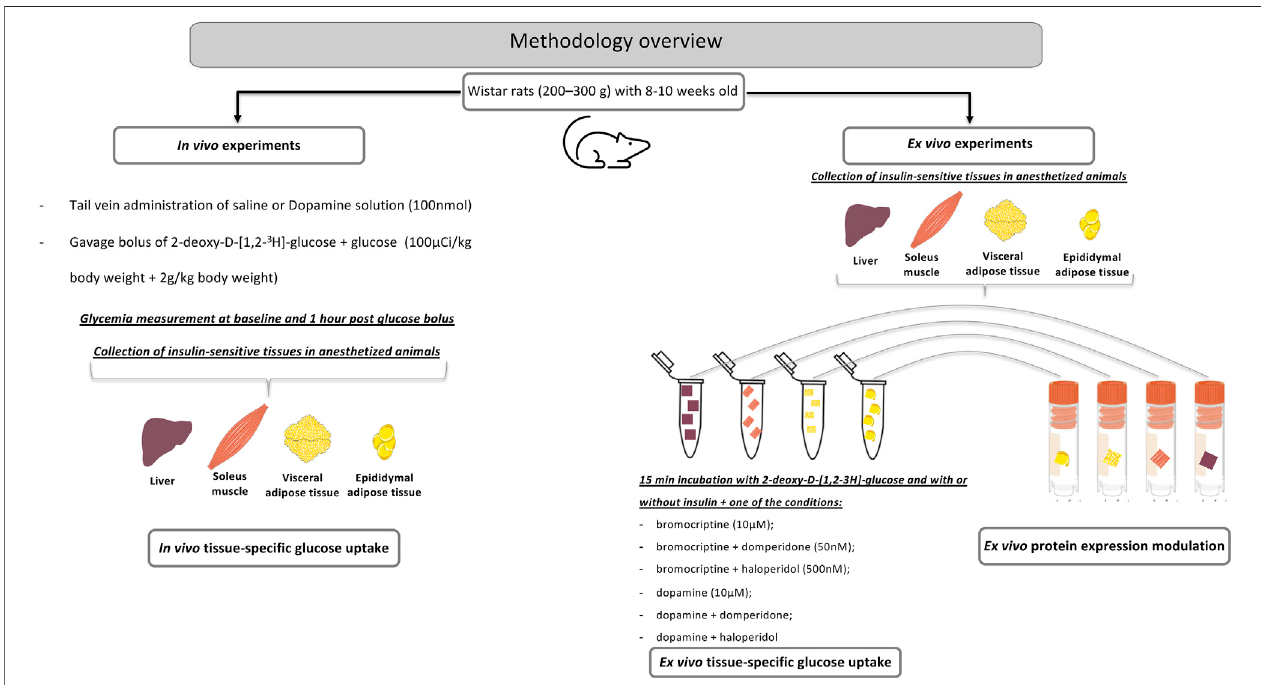
FIGURE 1 | A methodological overview for the in vivo and ex vivo experiments aimed to study the role of peripheral dopamine on insulin-sensitive tissues.